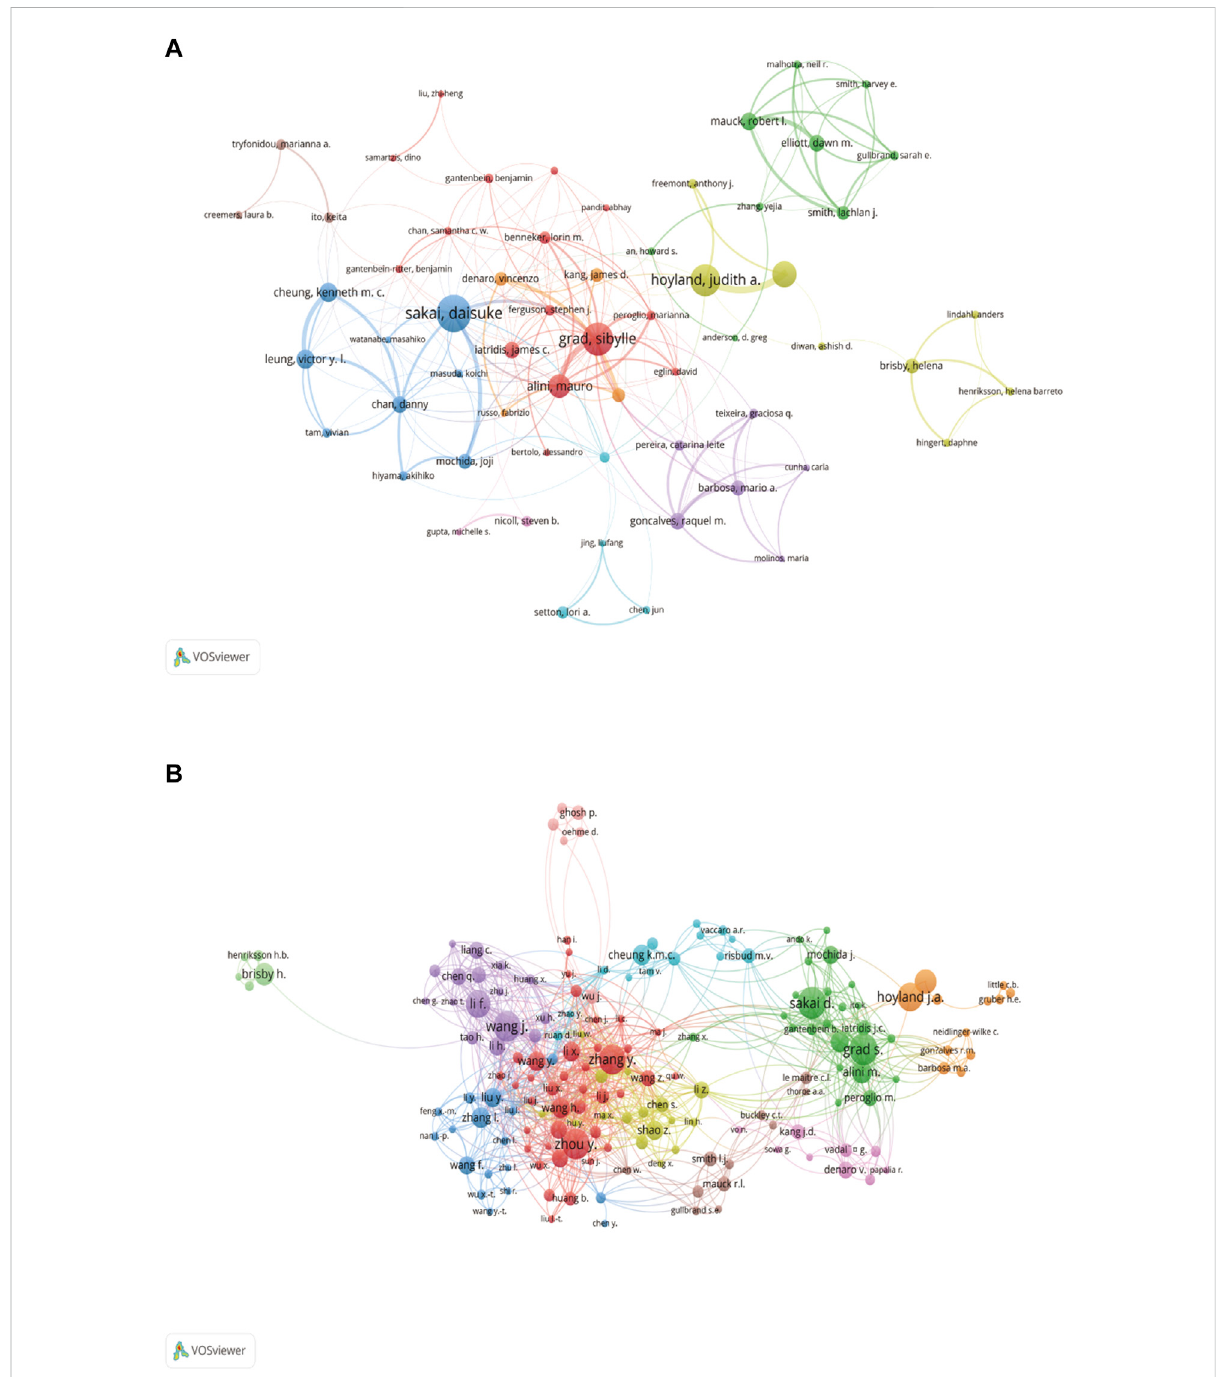
FIGURE 5 Cooperation networks between Authors in WOSCC (A) and Scopus (B) . Different colours represented different clusters, while authors cooperated with each other by linking lines, with thicker connections implying closer cooperation. A node represented an author, with larger segments indicating more publications. In WOSCC, key authors formed 9 clusters and 11 clusters were formed from